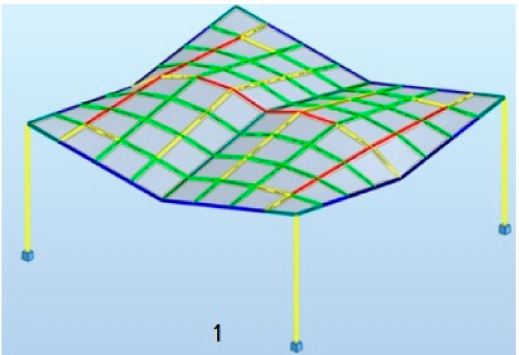
Figure 10. Maps on bars of the most efficient structures with cylindroid roofs.